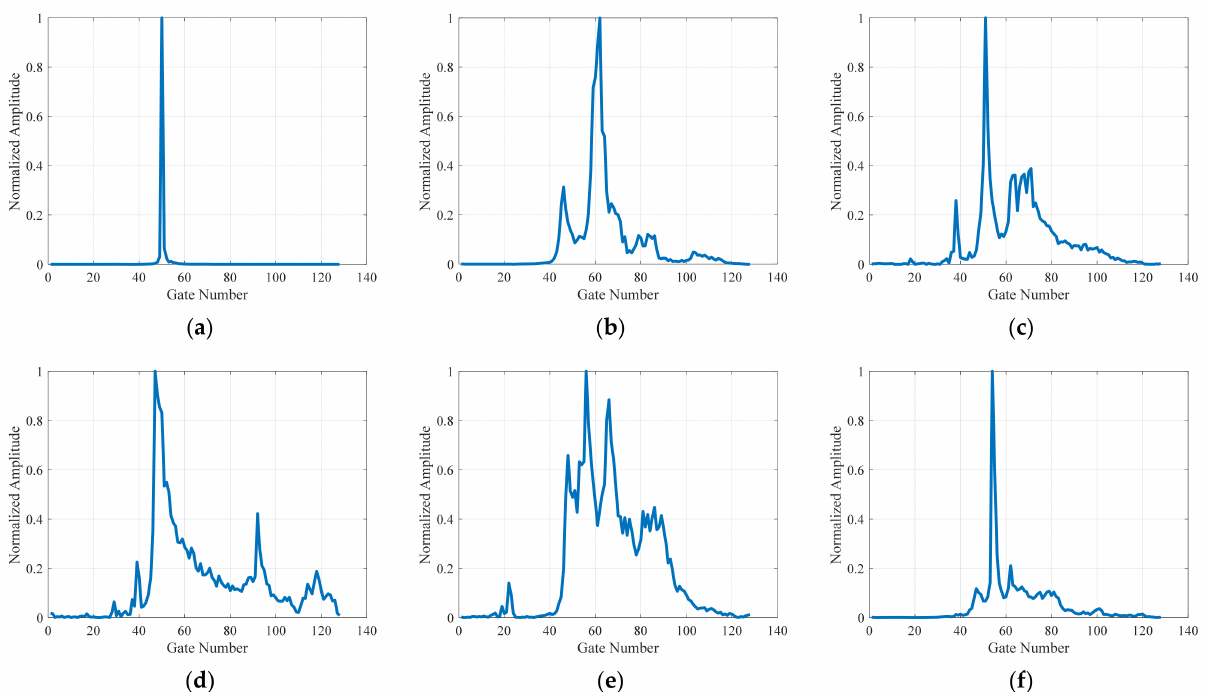
Figure 3. Some typical coastal waveforms in the experimental area, with ( a ) single-peak ( b ) double- peak ( c ) multi-peak ( d ) slight contamination and ( e , f ) heavy